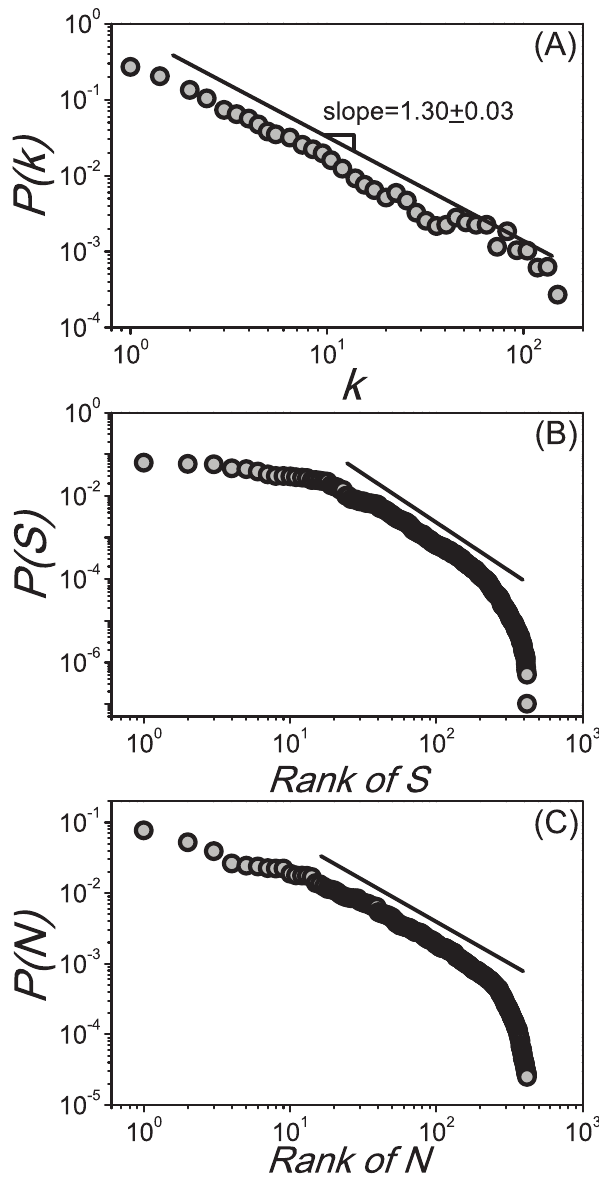
Figure 2. The heterogeneity of the USDAN’s infrastructure. (A) The degree distribution P ( k ) follows a power law pattern on almost two decades with an exponent 1.30 + 0.03. (B) shows that the probability- X v j ‘ , where u denotes rank distribution of the traffic outflux S j ~ ‘ [ u the set of neighbors belonging to the vertex j and the weight v j ‘ of a connection between two vertices ( j , ‘ ) is the number of passengers traveling a given route per day, is skewed and heterogeneously distributed. (C) shows that the probability-rank distribution of populations is skewed and heterogeneously distributed.